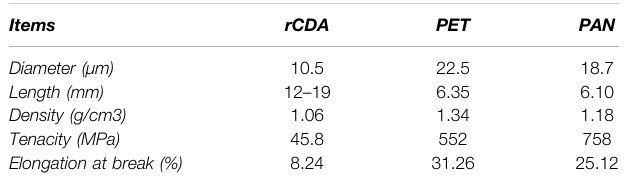
TABLE 1 | Properties of recycled cellulose diacetate, polyester, and polyacrylonitrile fi ber. Items